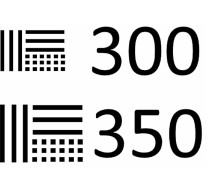
Figure 5. Sketch of a part of the used test chart, showing 300nm and 350nm